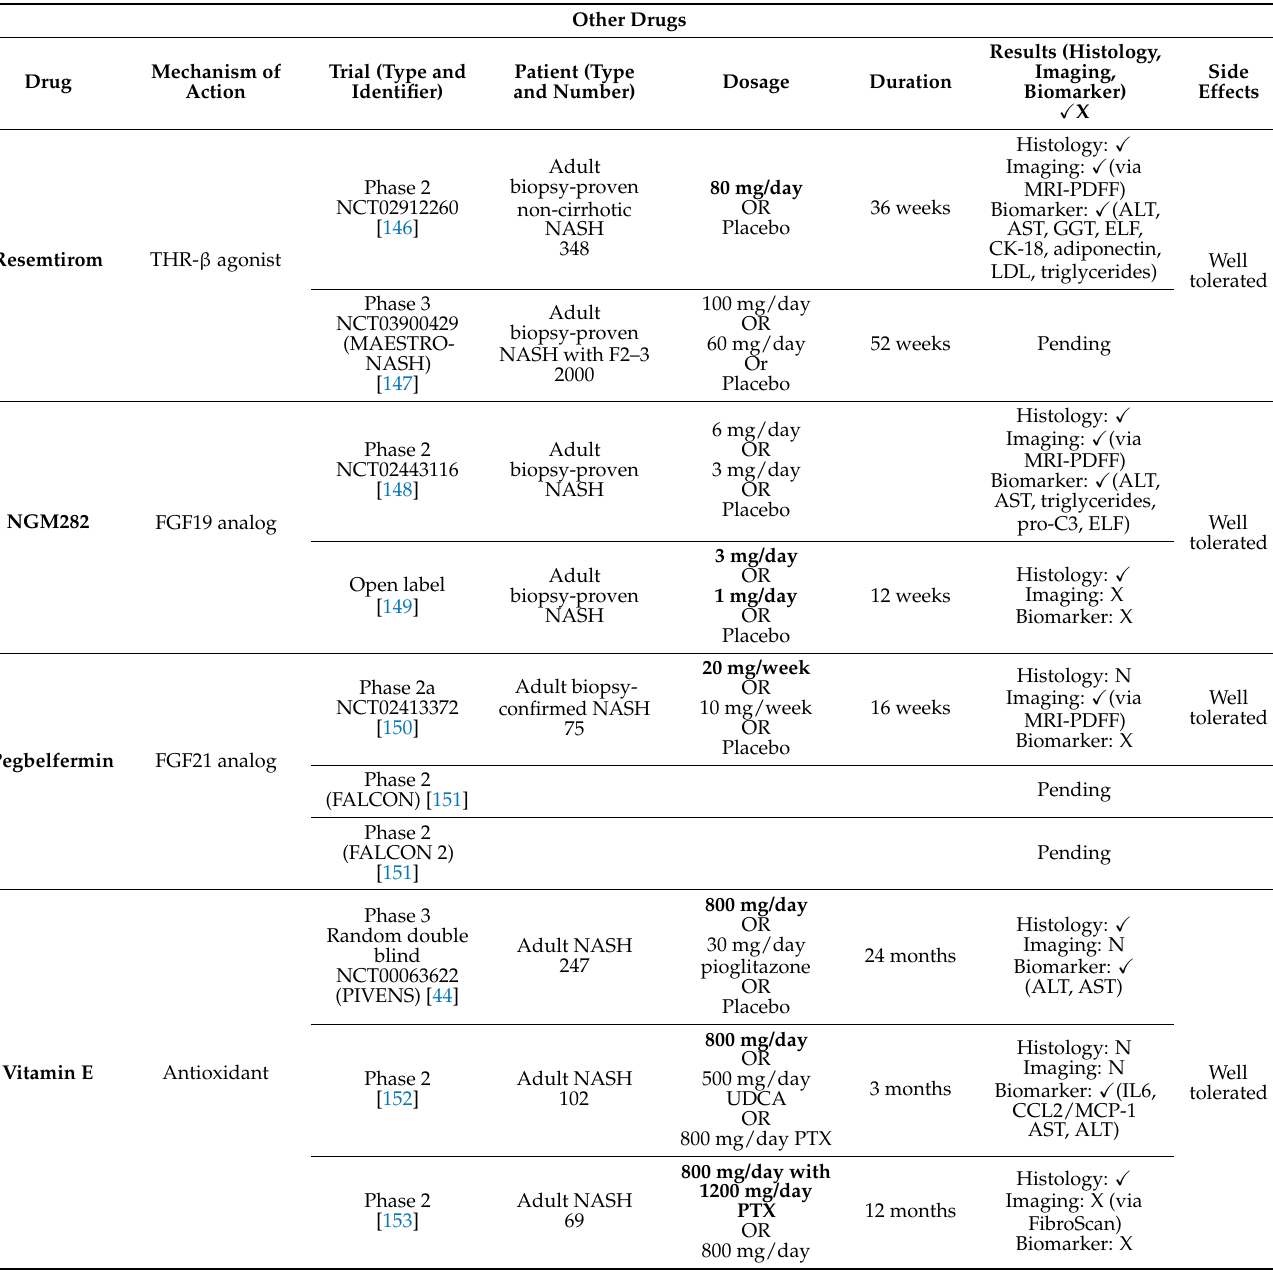
Table 9. Clinical trials on other drugs